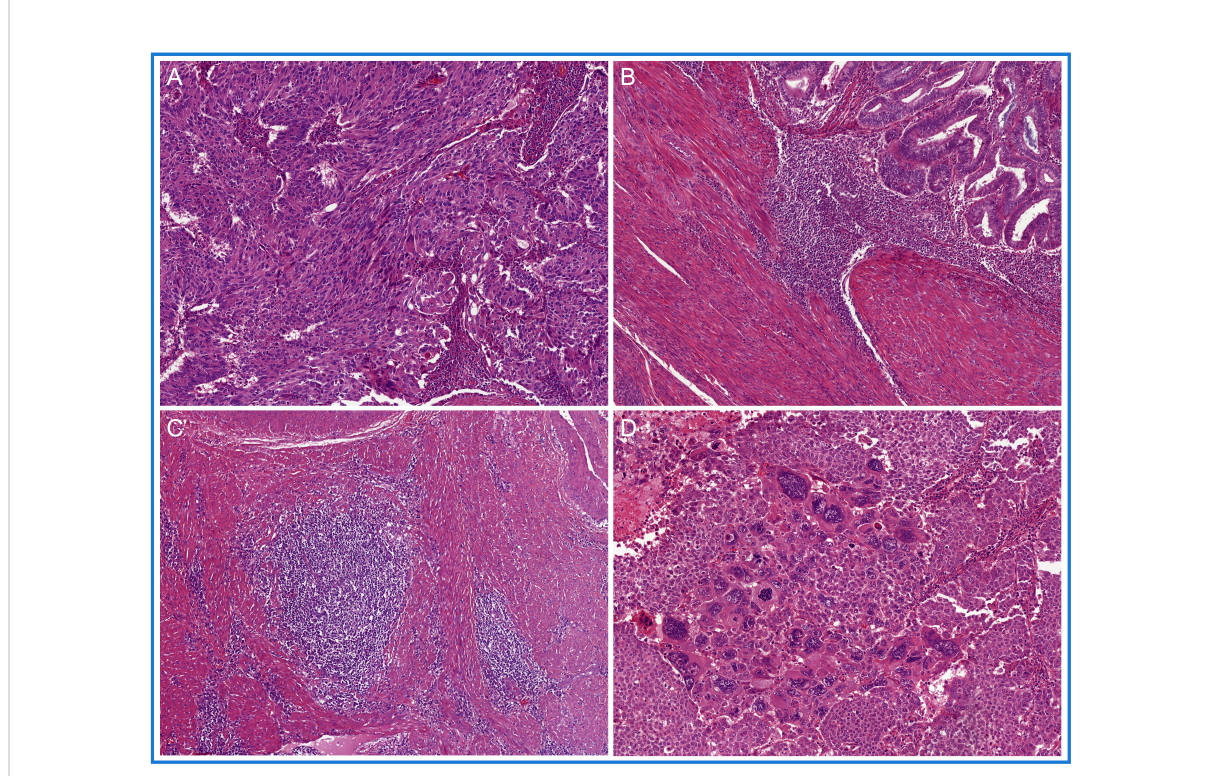
FIGURE 3 A selection of prototypical morphological features found in POLE- mutated endometrial cancer ( POLE mut EC): (A) at least 50% solid growth; (B) hyperchromatic tumor giant cells; (C) a dense peri-tumoral and intra-epithelial in fi ltrate of lymphocytes; and (D) tertiary lymphoid structures